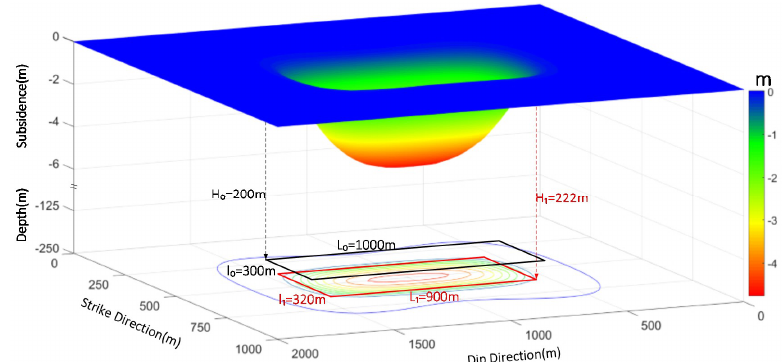
Figure 8. Comparison of locating results and simulated model. The black rectangle represents the real position of the goaf, and the red rectangle represents the calculated position of the goaf. H 0 , l 0 , and L 0 are the depth, width, and length of the real goaf; H 1 , l 1 , and L 1 are the depth, width, and length of the calculated